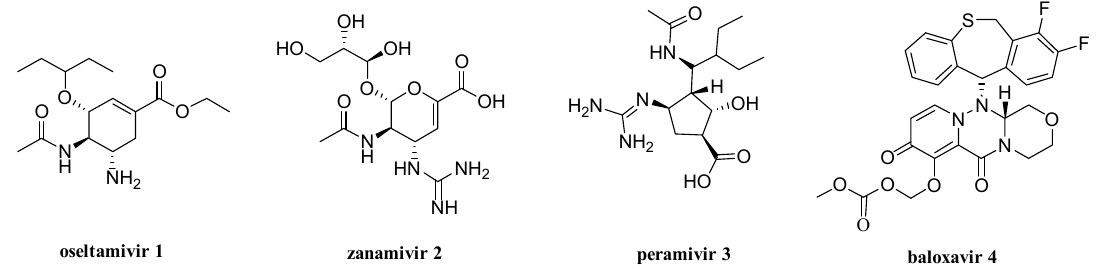
Figure 1. FDA-approved anti-flu drugs currently in use.